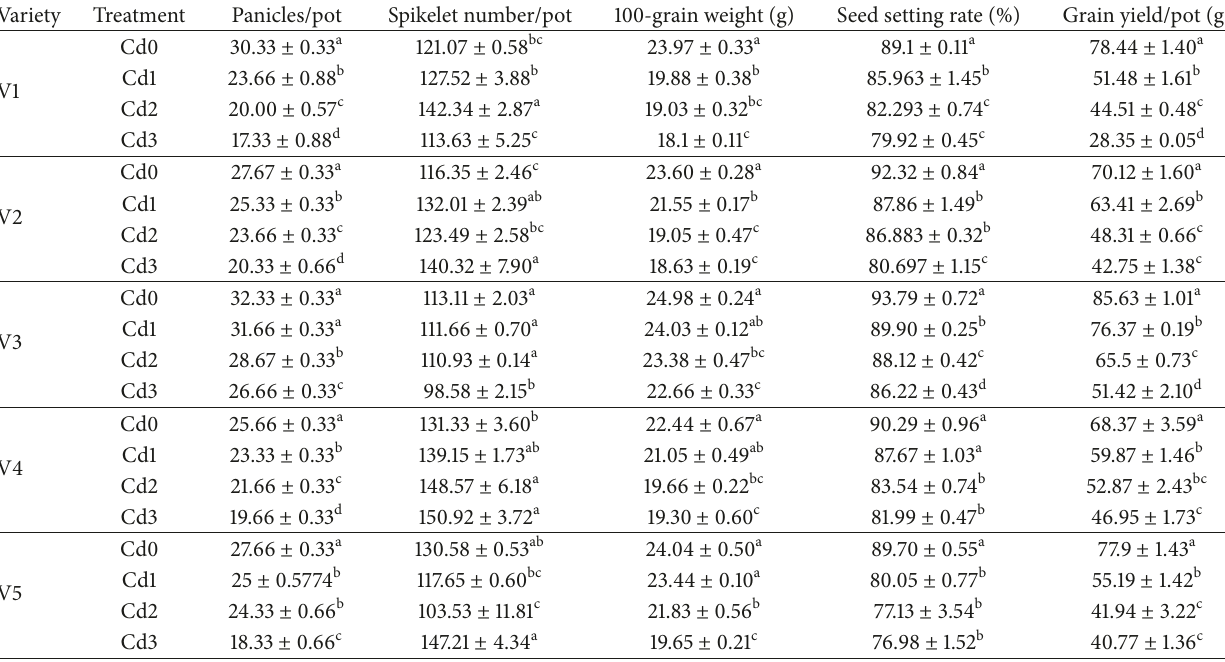
Table 2: Effects of cadmium on yield and its